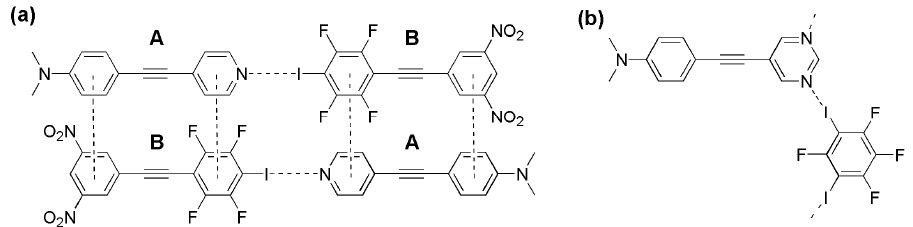
Figure 1. ( a ) Cooperative halogen bonding and EDA π -stacking in cocrystal A•B [12]. ( b ) Ditopic halogen bonding in cocrystals formed between 5-( N , N -dimethylaminophenylethynylpyrimidine and 1,3-diiodotetrafluorobenzene [13].